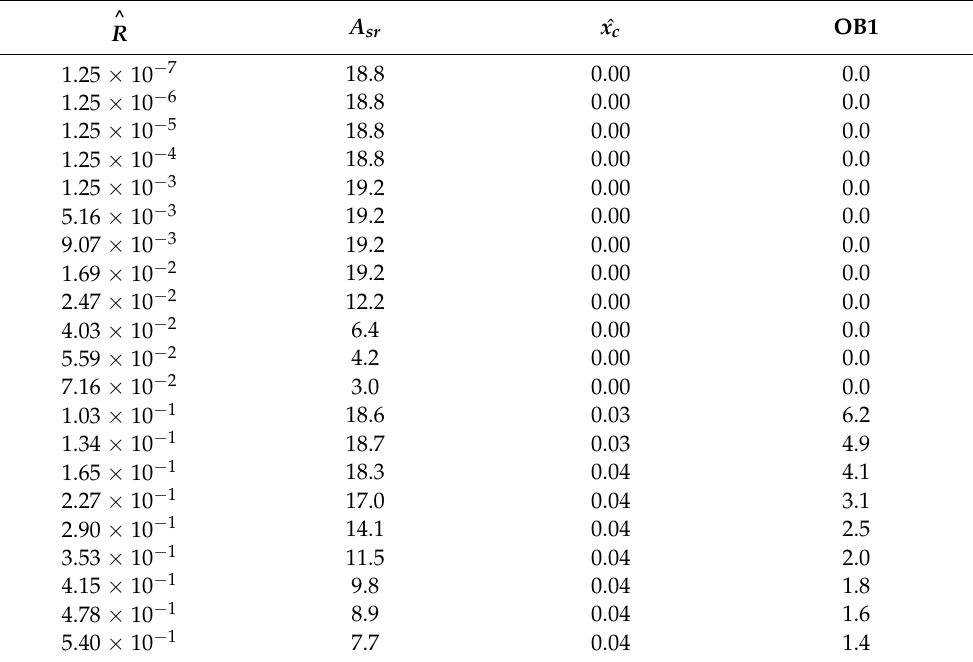
Table 3. Optimized dimensionless parameters for an RPSPV system using an objective function of Equation (34) at the surge tank connector.